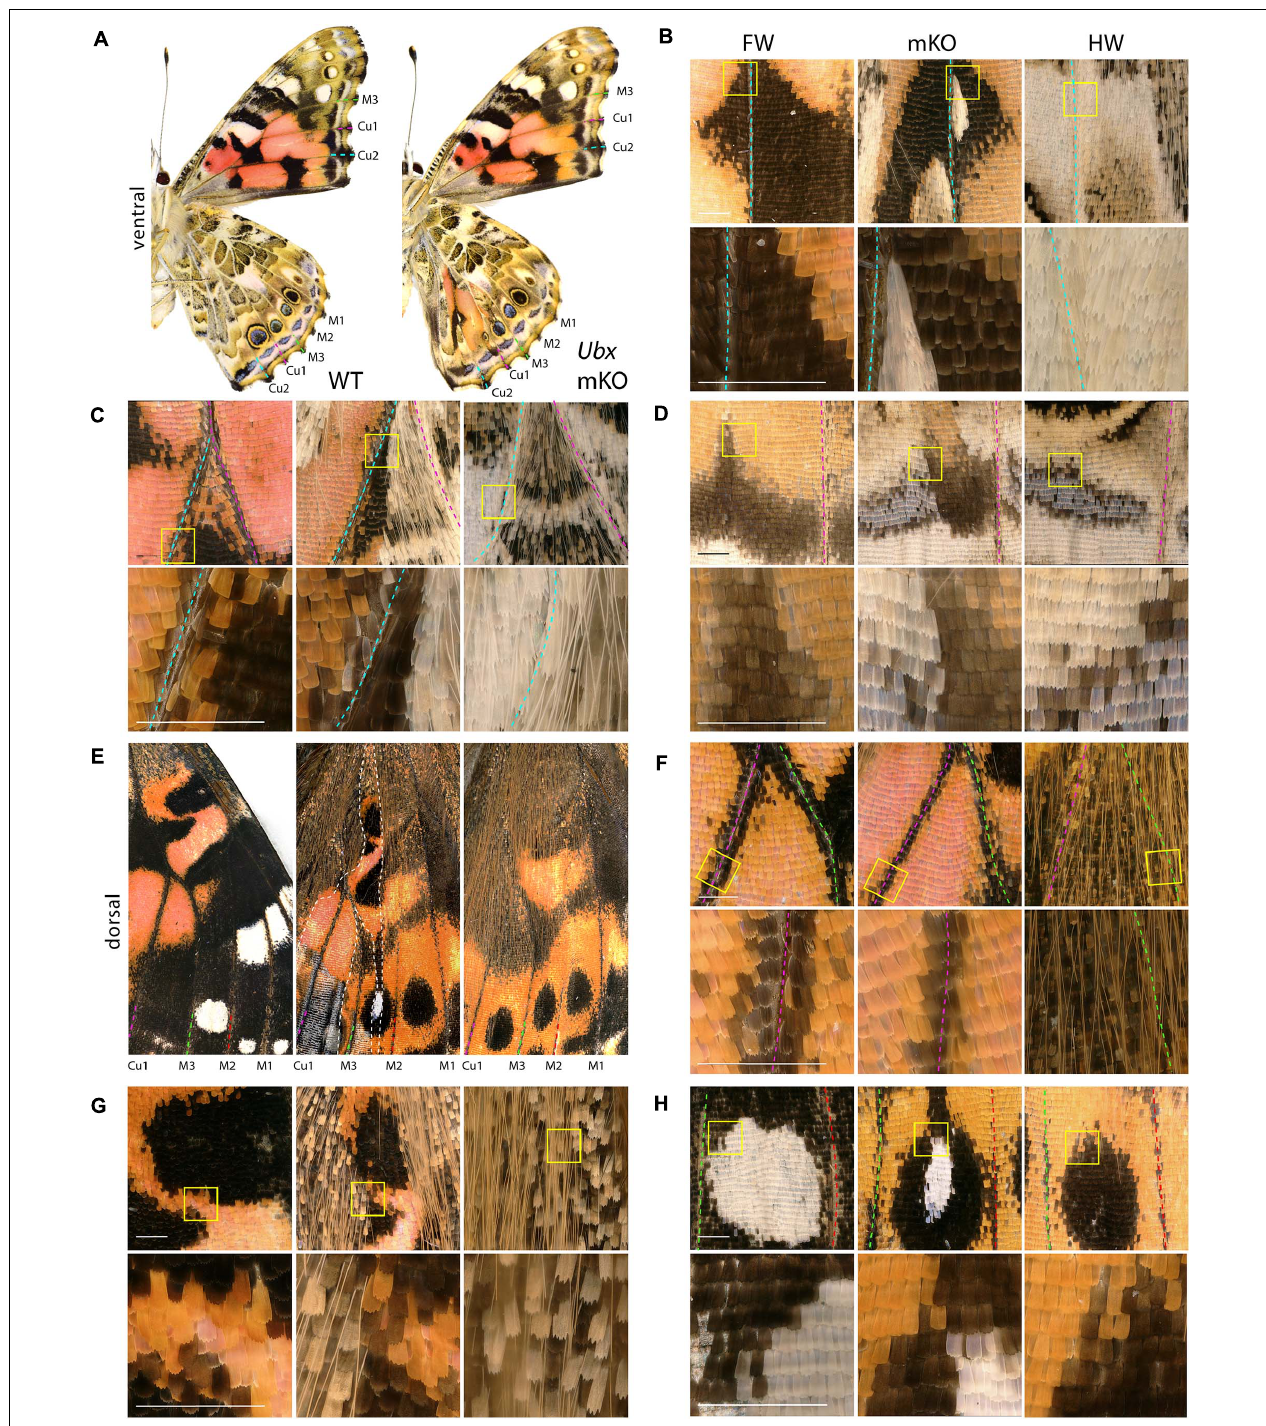
FIGURE 3 | Homeotic transformations of hindwing color patterns after Ubx mosaic knock-out in V. cardui. Panels (B–H) each show tripartite comparisons of positionally matched patterns from a forewing (left), a mutant hindwing (center), and a WT hindwing (right). Lower panel depicts magnification of yellow insets in the upper panel. (A) Ventral side of WT and an Ubx mKO individual in V. cardui , with magnified views in panels (B) (median Cu2), (C) (Cu1–Cu2 vein junction), and (D) (Cu1–Cu2 distal parafocal element). (E) Comparison of a dorsal forewing area, and the corresponding region of the mutant and WT hindwing, with an elongated mutant clone resulting in homeoses, as magnified in panels (F) (Cu1–M3 vein junction), (G) (Discalis II elements), and (H) (M2–M3 eyespot). The wildtype forewing in panel E was shrunk to 75% of its original length to adjust for allometric differences with the hindwings. Scale bars = 500 µ m.